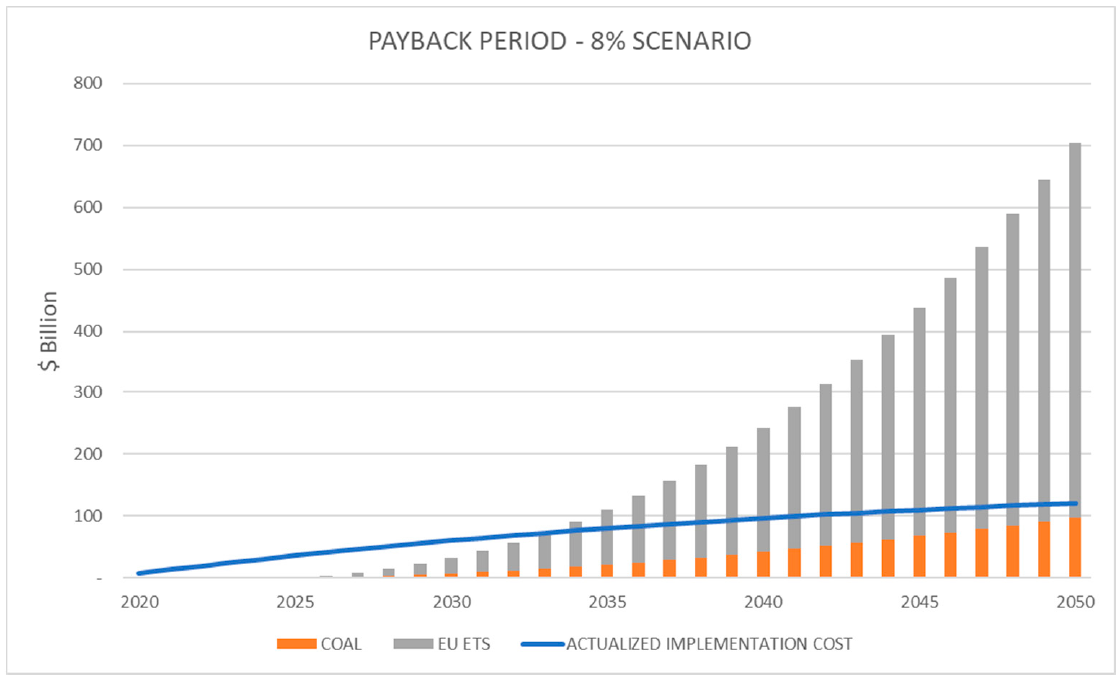
Figure 10. Payback period in the 8% scenario.